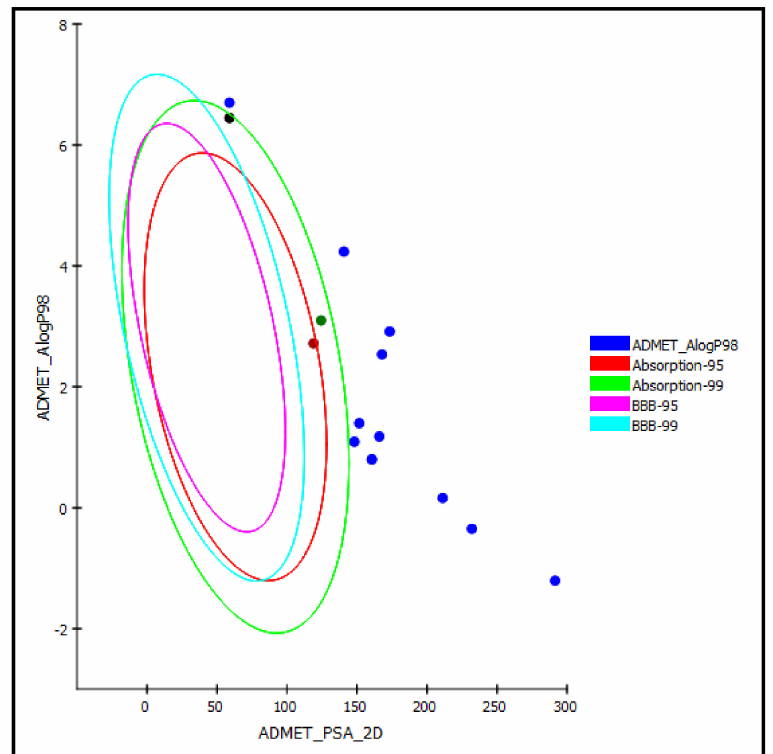
Figure 7. ADMET Plot of the 2D polar surface area (PSA_2D) against calculated ALogP98 for examined triterpenes, showing the 95% and 99% confidence limit ellipses corresponding to the blood–brain barrier (BBB) and to the human intestinal absorption models; compound 4 (green dot), compound 5 (red dot), and compound 14 (black dot) are (just) within acceptable boundaries for some penetration in ADMET_AlogP98.